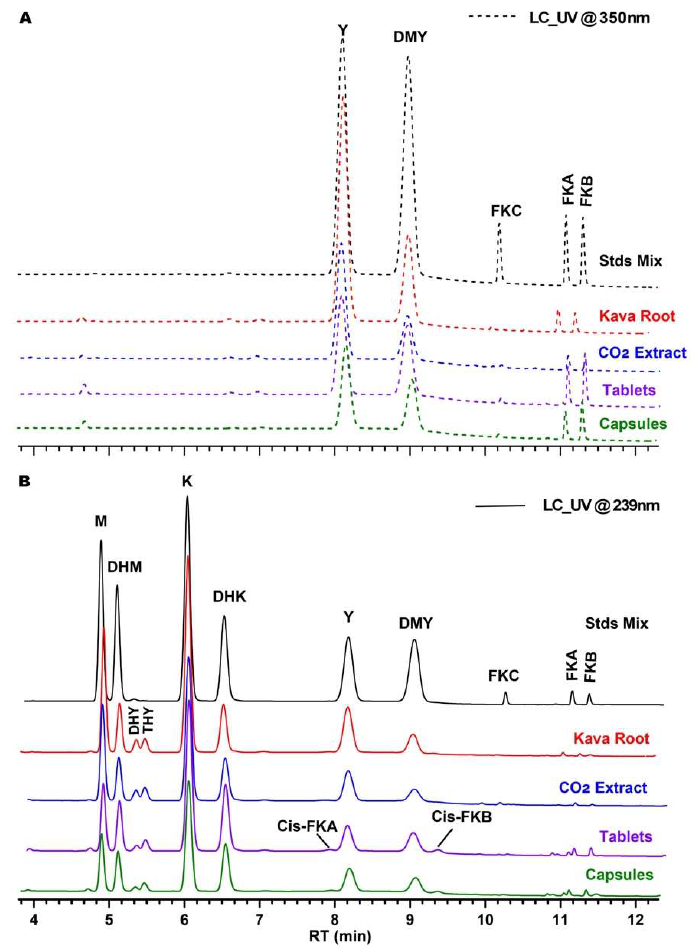
Figure 4. UHPLC chromatography of kava standard mixture and kava products. ( A ) UV trace at the